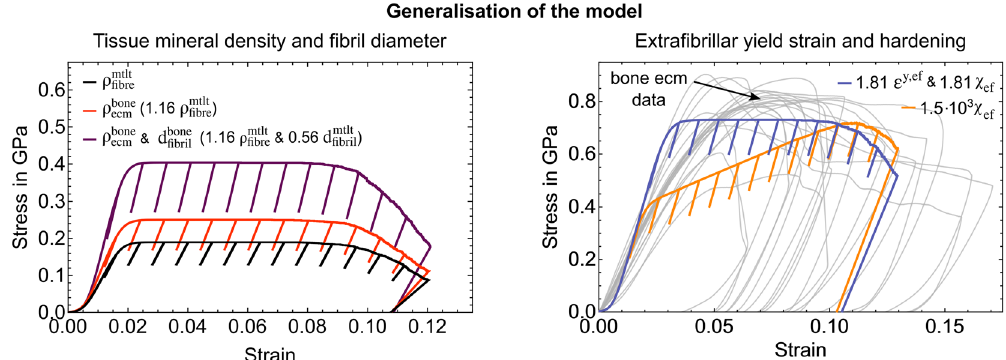
Figure 8. Model generalisation towards cortical bone. (Left) Simulated fibre stress-strain using the higher bone tissue mineral density ρ 68 ( red ) and combined with the smaller bone fibril diameter d 1,81,82 ( magenta ); original composition in black . (Right) Simulated fibre stress-strain when accounting for an effective increase of the fibrils surface area per unit mass within the extrafibrillar matrix due to a smaller fibril diameter leading to a change in fibril-matrix interaction. Blue : Increased extrafibrillar yield strain and hardening. Orange : Sole and very high increase of hardening necessary to reach the bone compressive strength at ecm level 28 . The grey curves represent experimental micropillar compression data of bone extracellular matrix 28 . The model was run with a 75% lower surface roughness based on experiments 28